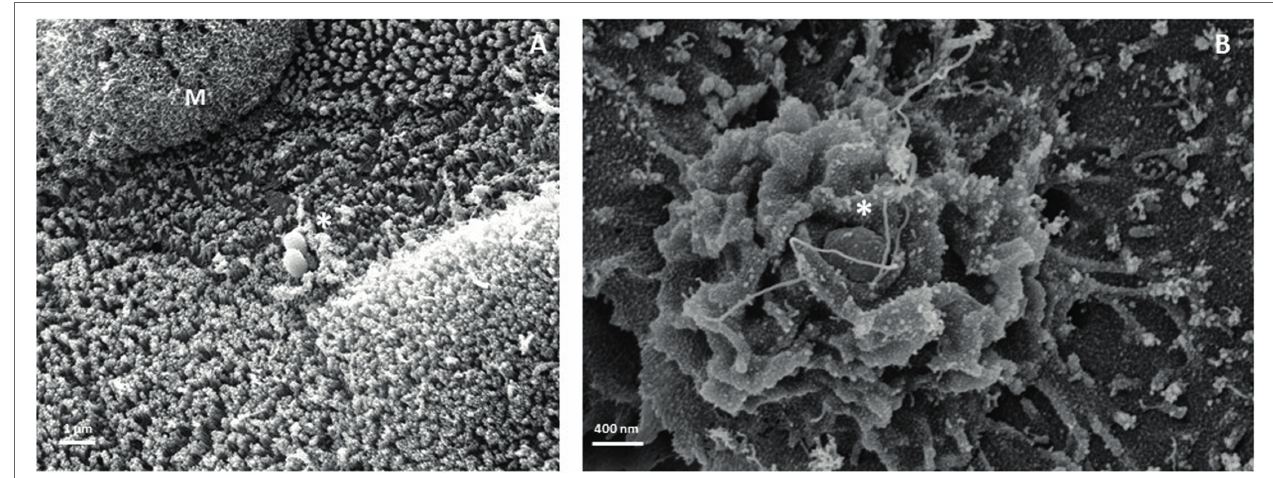
FIGURE 4 | Membrane structures during STm invasion at the apical site of human monolayer organoid derived from colon. Representative image obtained by scanning electron microscopy of discreet (A) and strong (B) membrane rearrangements. Star indicates STm membrane rearrangement at the entry site. M, mucus. Scale bar: (A) 1 μ m (B) 400